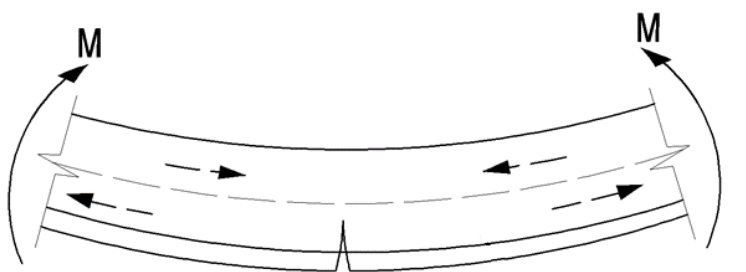
Figure 2. General view of a bent beam with a crack.